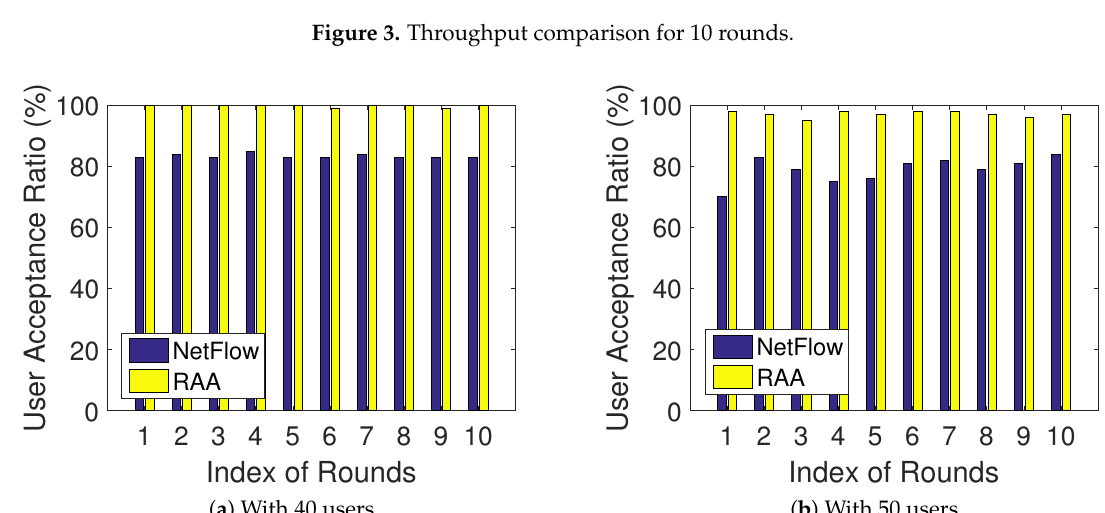
Figure 4. User acceptance ratio comparison for 10